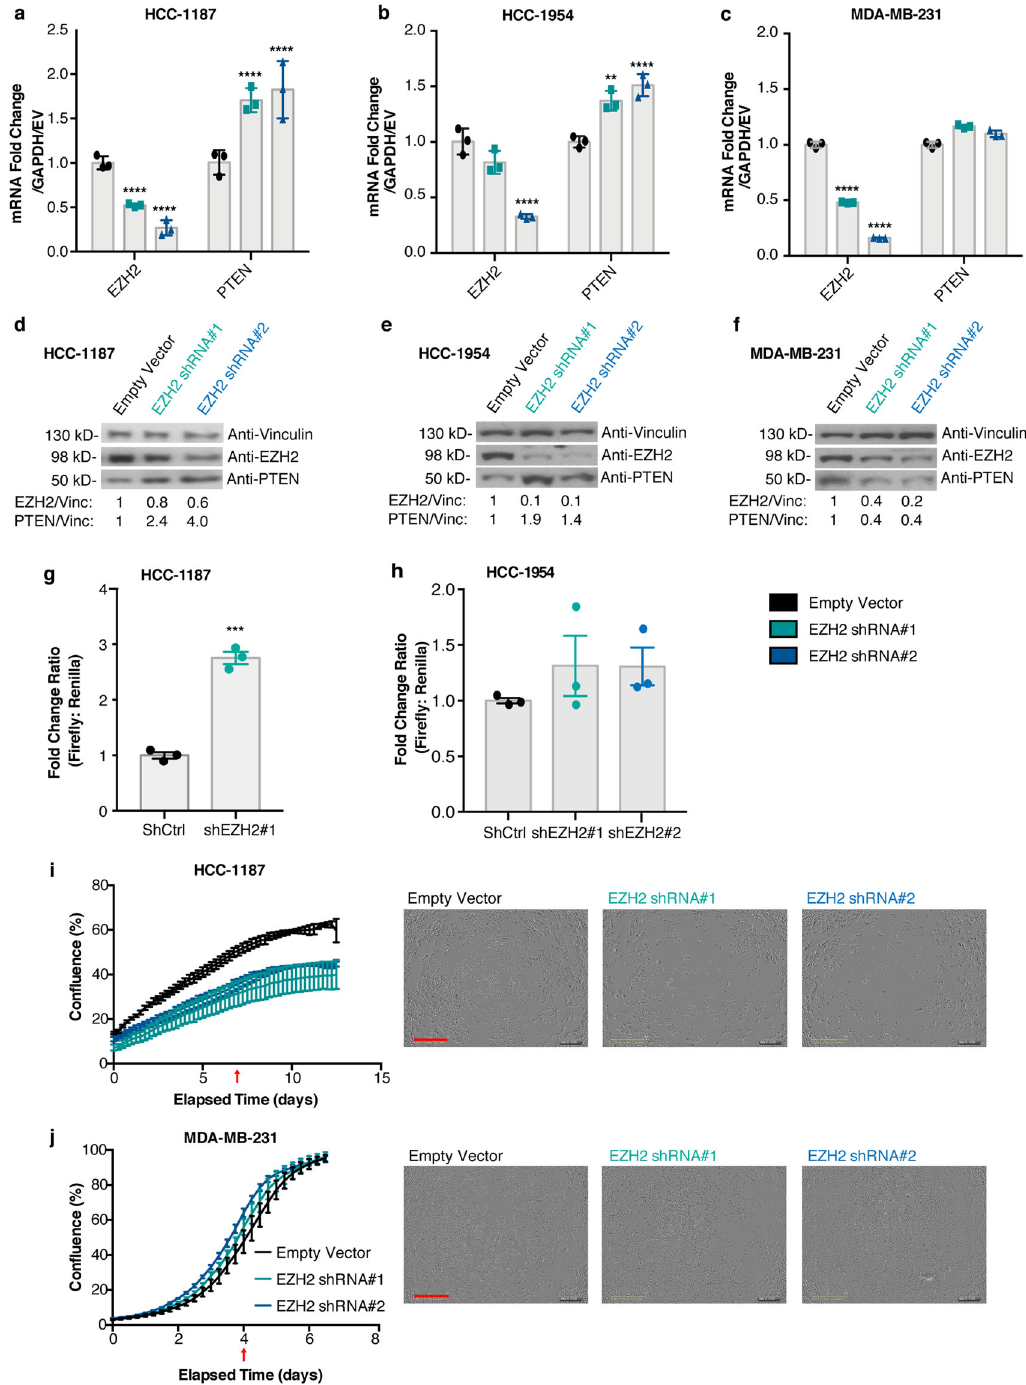
Fig. 3 Depletion of EZH2 restores PTEN expression and reduces proliferation in a subset of cell lines. Stable shRNA knockdown of EZH2 was performed. EZH2 and PTEN transcript levels were measured by qRT-PCR ( a – c ) and protein levels were measured by immunoblotting in ( d – f ) HCC-1187 cells, HCC- 1954 cells, and MDA-MB-231 cells, respectively. Vinculin was loading control. Quanti fi cation is shown below each blot (signal normalized to Vinculin, calculated as a fold change compared to Empty Vector). Error bars: mean ± s.d. (triplicate measurements). Signi fi cance from Ctrl: two-way ANOVA, Tukey ’ s correction. Luciferase activity at the PTEN promoter was measured (Pgl-1 from Fig. 2a) following stable knockdown of EZH2 in ( g ) HCC-1187 and ( h ) HCC-1954 cells. Error bars: mean ± s.e.m., n = 3 experiments. Proliferation was measured following EZH2 knockdown, the percentage of con fl uence over time (days) is displayed in ( i ) HCC-1187 cells and ( j ) MDA-MB-231 cells. Readings taken every 6 h. Error bars: mean ± s.d., triplicate measurements. Corresponding representative photos from indicated timepoints (red arrow) shown, Scale bar (red): 800 µ m. Signi fi cance from Ctrl: two-way ANOVA, Tukey ’ s correction. (**** P < 0.0001; *** P < 0.001; ** P <